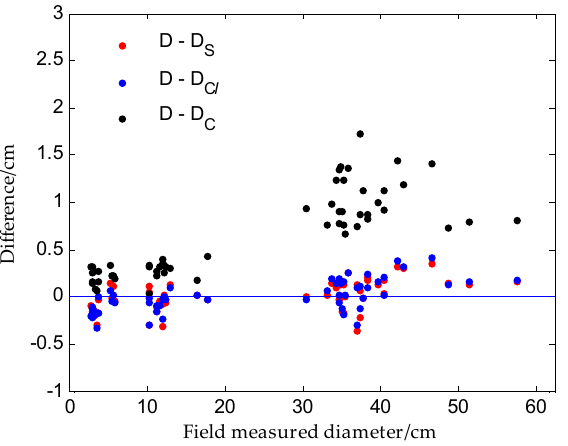
Figure 7. Differences between the field-measured diameters and diameters retrieved from stem points.